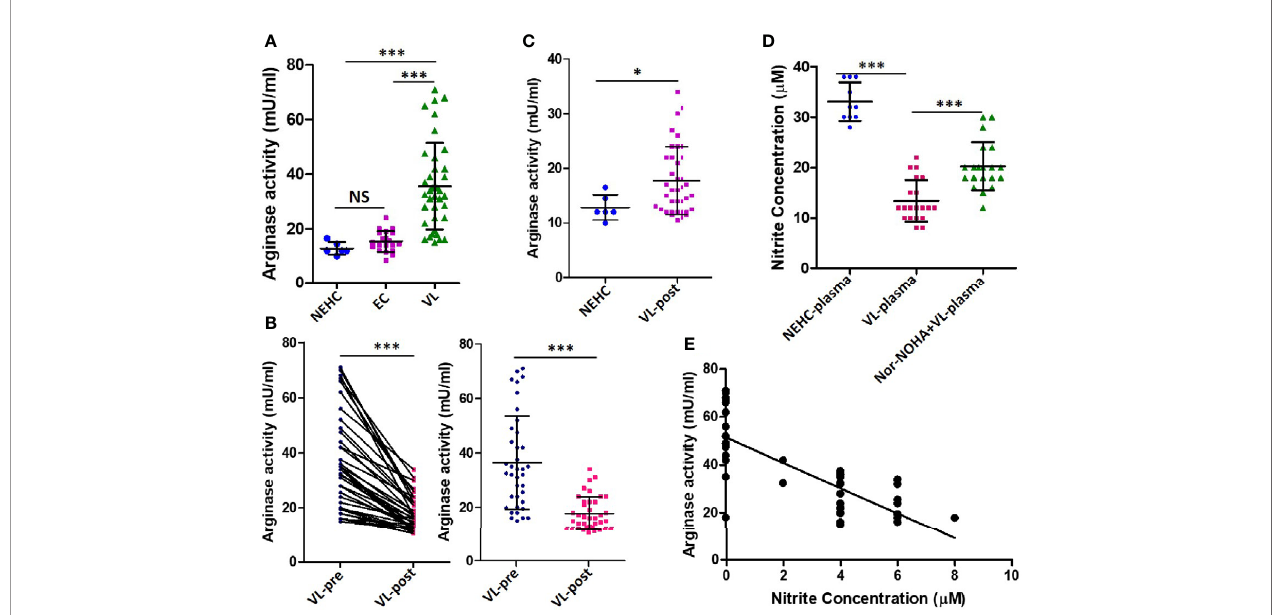
FIGURE 3 | Arginase activity levels in the plasma of VL patients, ECs and NEHCs. (A) Whole blood was centrifuged to collect plasma from VL patients (VL; n=38) (circles), endemic controls (EC; n=20) (squares) or non-endemic healthy controls (NEHC; n=6) (triangles). Arginase activity in the plasma was measured by a colorimetric assay as detailed in the Methods section. A two-tailed Mann-Whitney test was performed to compare the statistical differences between groups. (B) Same as in panel A, but a before and after plot for paired VL plasma samples (n=38), i.e., VL patients at presentation (circles) and after completion of treatment (squares). Wilcoxon signed rank test was applied for statistical signi fi cance. (C) Comparison of arginase activity in the VL patients post-treatment with those of NEHCs. (D) PBMCs were isolated from the blood of NEHCs and incubated with VL plasma alone or in the presence of an arginase inhibitor, Nor-NOHA (n=20) for 12 h. Nitrite concentration was estimated in the cell-free supernatant after stimulation of the cells with IFN-a (500 U/ml) for 48 h as described in the Methods section. A two-tailed Mann-Whitney test was performed to compare the statistical differences between groups. (E) A correlation plot between arginase activity and plasma nitrite concentration. Mann-Whitney test; *p < 0.05, ***p < 0.001; NS, not signi fi cant; PBMC, peripheral blood mononuclear cell; VL, visceral leishmaniasis; EC, endemic control; NEHC, non-endemic healthy